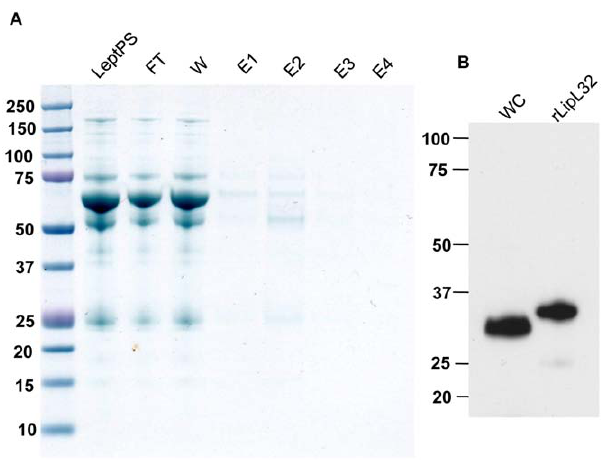
Figure 2. Purification and specificity of LipL32 antibodies from leptospirosis patient sera. (A) Affinity purification of LipL32-specific antibodies. Recombinant LipL32 [17] was coupled to an AminoLink Plus column. Pooled convalescent sera from 23 individuals with laboratory- confirmed leptospirosis was added to the LipL32-affinity column. The chromatography products were analyzed by gel electrophoresis (Bis- Tris 4–12% NuPage gel, Novex), and Coomassie G250 staining. Abbreviations: LeptoPS, leptospirosis patient sera (pooled); FT, flow- through fraction; W, fraction after washing with PBS; E1-E4, eluted IgG fractions. (B) Extract of 1 6 10 8 leptospires (lane WC) or 0.5 m g of recombinant LipL32 (lane rLipL32) were separated by gel electropho- resis, blotted onto PVDF membrane, and probed with affinity purified LipL32 IgG fraction E2 (1:200).